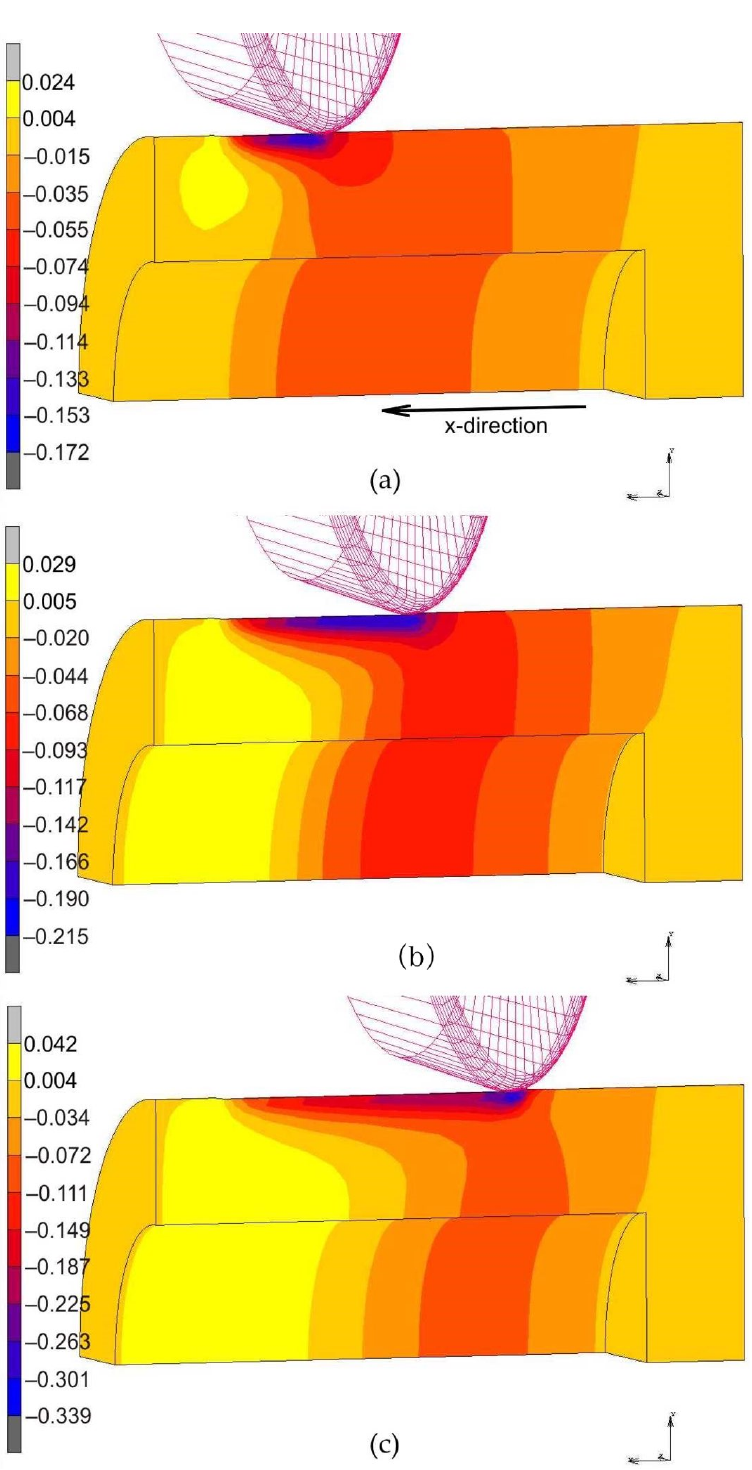
Figure 18. Displacement of the material in the x-direction during roller burnishing with braking moment across the width of the rings packet at a distance of: ( a ) 10 mm, ( b ) 20 mm and ( c ) 30